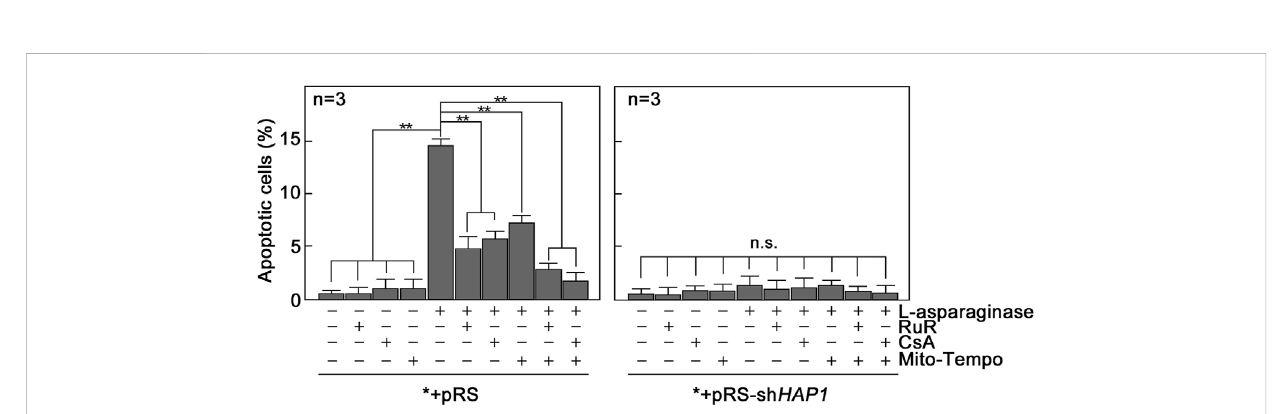
FIGURE 7 Blocking ER-mitochondria Ca 2+ transfer by RuR, mPTP formation by CsA and/or mitochondrial ROS production by Mito-Tempo inhibit L-asparaginase-inducedapoptosis.*+pRSand*+pRS-sh HAP1 cellspre-treatedwithRuR,CsAorMito-TempothenstimulatedwithL-asparaginasewere stained with Hoechst 34580 and FITC-Annexin V. FITC-positive apoptotic cells were counted 12 h post-treatment at ×10 magni fi cation using a I×71 Olympus inverted microscope attached to a 37 ° C incubator with 5% CO 2 . The percentage of apoptotic cells was determined from a fi eld of ~100Hoechst34580-stainedcellsusingtheOlympusCellSenssoftware(Olympus,Japan).Valuesaremeans±SEMfromthreeindependentexperiments ( n = 3). ** p < 0.05. N.S. not signi fi